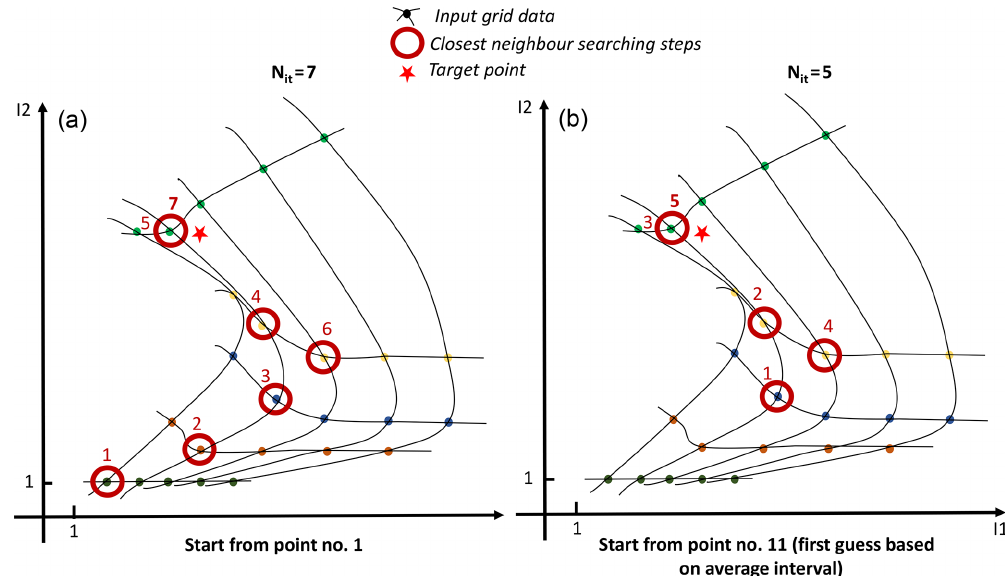
Figure 2. Real example in 2-D of the step-by-step procedure to find the nearest neighbour of a target point for an irregular but structured 5 × 5 grid (a) when starting the process from the first point of the grid on the lowest left corner and (b) when starting with a first guess based on an average delta computed for each dimension.